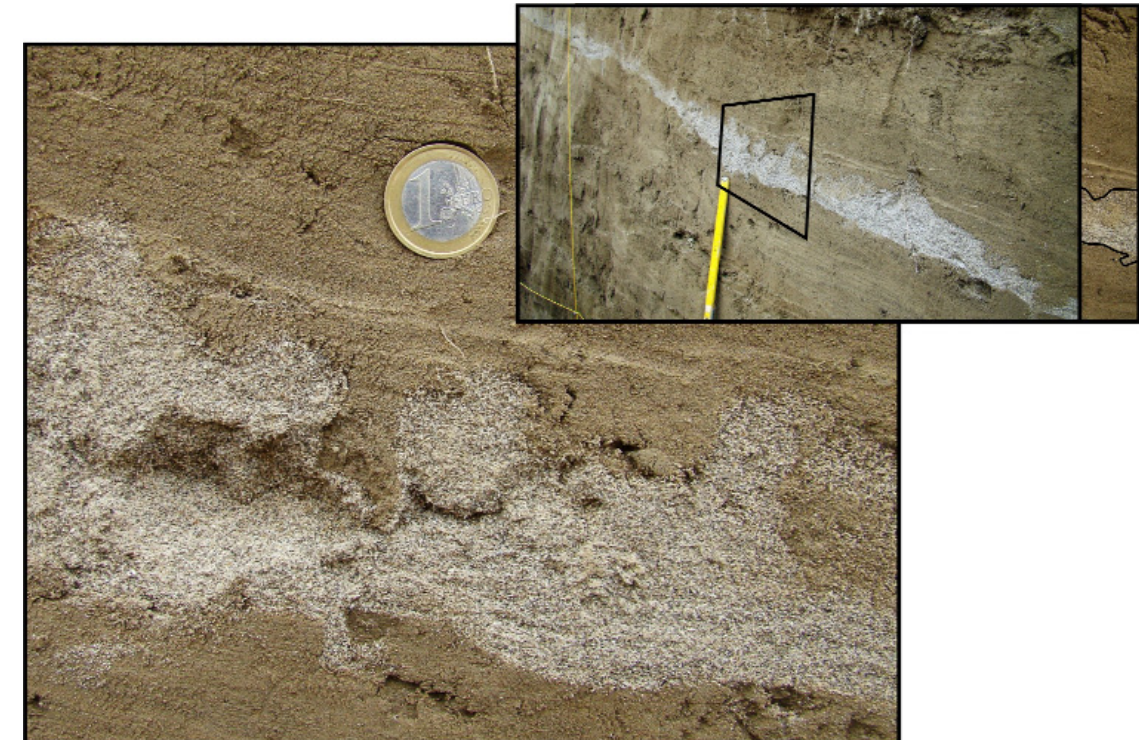
Figure 6. Example of 'load structures' that affect the channel-related deposits. See Figure 3 for location in the trench